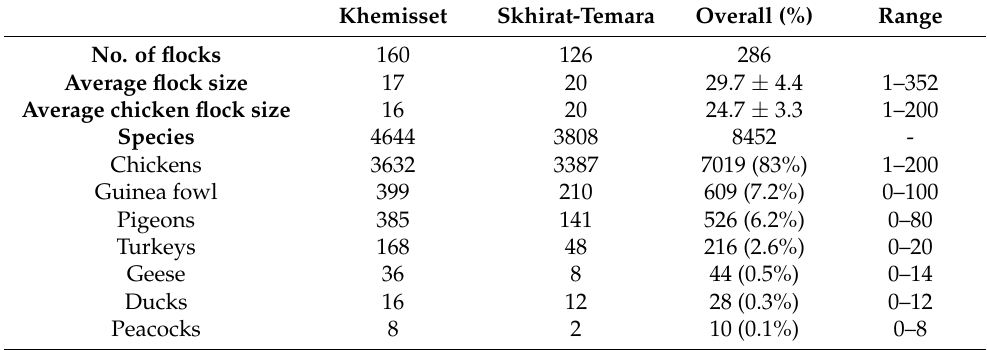
Table 2. Backyard flock species distribution and average flock size among the surveyed